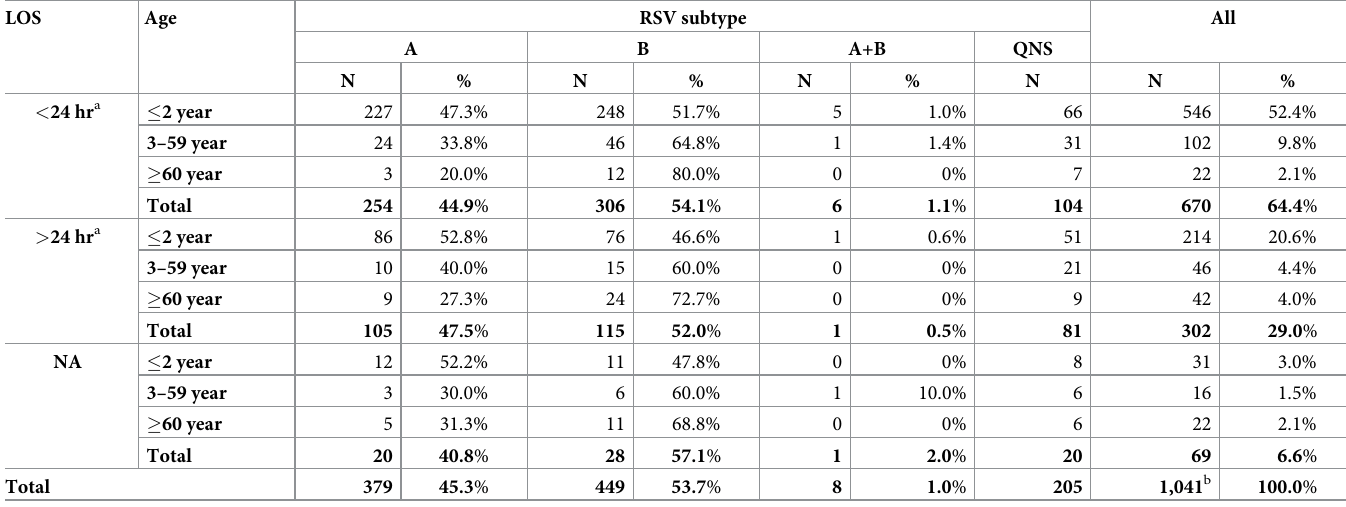
Table 3. OUTSMART 2016–17 RSV-positive tests by LOS, age and